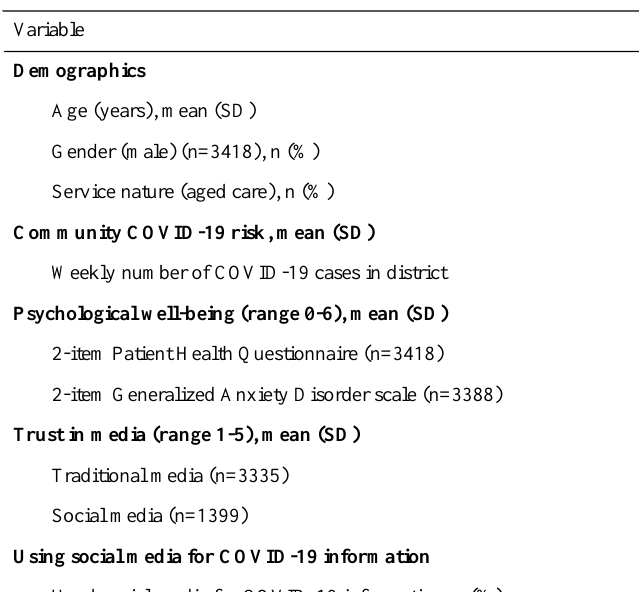
Table 1. Respondent